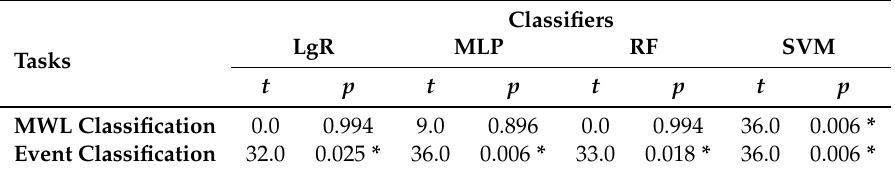
Table 5. Summary of one-sided Wilcoxon signed-rank tests [59] on the average performance in 10-fold CV of classification tasks by different classifiers trained with MI and EEG based features. The significant values i.e., p < 0.05, are marked with asterisks ( * ).